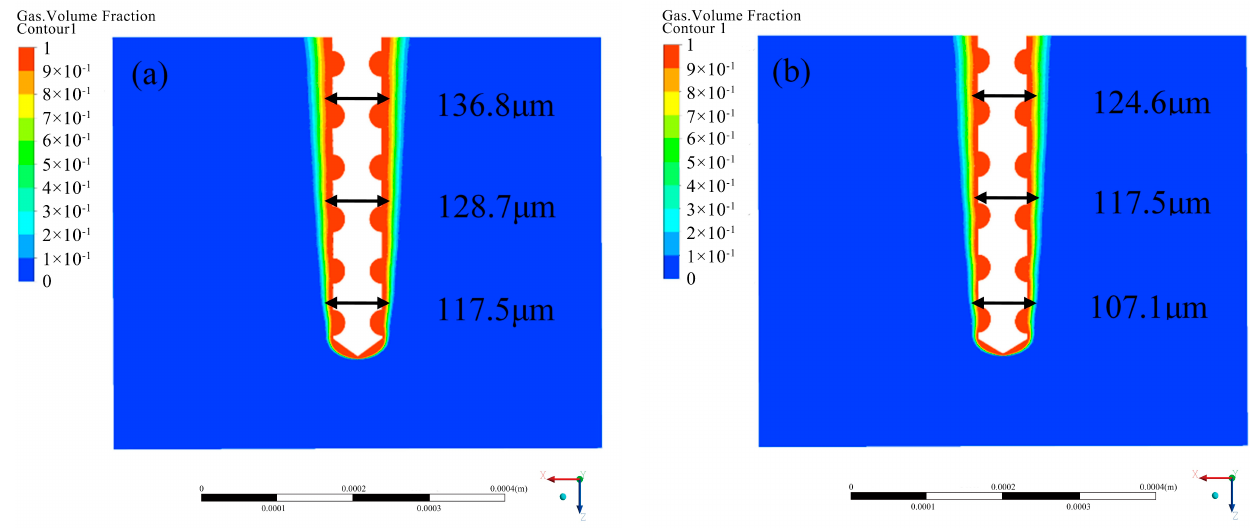
Figure 6. Effect of ultrasonic vibration on gas film. ( a ) Without ultrasonic vibration assistance. ( b ) With ultrasonic vibration assistance.